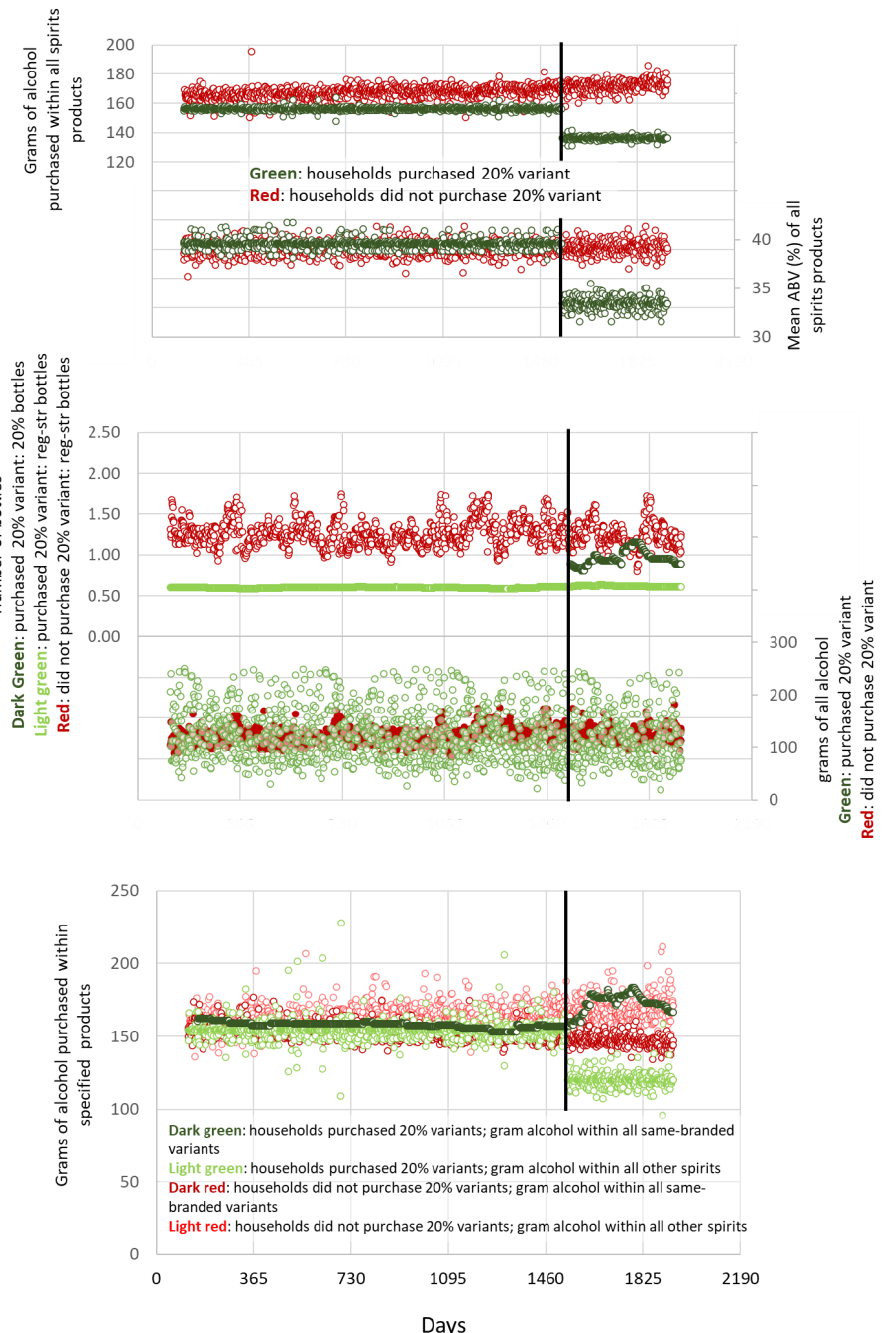
Figure 2. Households that had bought at least one variant of the same-branded whisky or gin, divided into those that had bought the newly introduced 20% variant (green) and those that had not (red). Top graph: total grams of alcohol purchased per day of purchase per study day within any spirit product and mean ABV of any purchased spirit product. Middle graph : number of bottles of whisky and gin purchased (adjusted to 700 mL and smoothed per week) and total grams of alcohol purchased per day of purchase per study day. Bottom graph : total grams of alcohol purchased within any variant of whisky and gin and within any other spirit product per day of purchase per study day. Vertical line : introduction of 20% variant, as identified by first household purchase. Data points : daily, with exponential